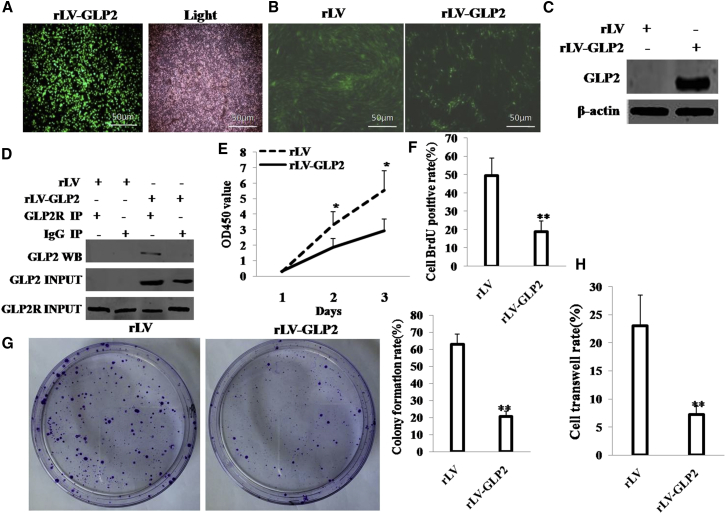
GLP2 Inhibits Osteosarcoma Carcinogenesis In Vitro(A) The photography of the HEK293 cell lines infected with rLV-Green-GLP2. (B) The photography of the MG63 cell lines infected with rLV-Green or rLV-Green-GLP2. (C) Western blotting with anti-GLP2 in MG63 infected with rLV-GLP2 or rLV. β-actin was used as an internal control. (D) Co-Immunoprecipitation (coIP) with anti-GLP2R followed by western blotting with anti-GLP2 in MG63 cells infected with rLV or rLV-GLP2. IgG IP as negative control. INPUT refers to western blotting with anti-GLP2 and anti-GLP2R. (E) Cell proliferation assay was performed in 96-well format using the CCK8 cells proliferation kit to determine the cell viability as described by the manufacturer. Each sample was assayed in triplicates for 3 days consecutively.Cell growth curve was based on the corresponding the relative values of OD450 and each point represents the mean of three independent samples. Data are means of value from three independent experiments (error bar ± SEM; *p < 0.05). (F) Cell BrdU assay. Data are means of value from three independent experiment (error bar ± SEM; **p < 0.01). (G) (left)The photography of colonies from the cell lines indicated in left. (right) Cell plate colony formation ability assay. Data are means of value from three independent experiment, bar ± SEM. (H) Cell transwell assay. Data are means of value from three independent experiment (error bar ± SEM; **p < 0.01).